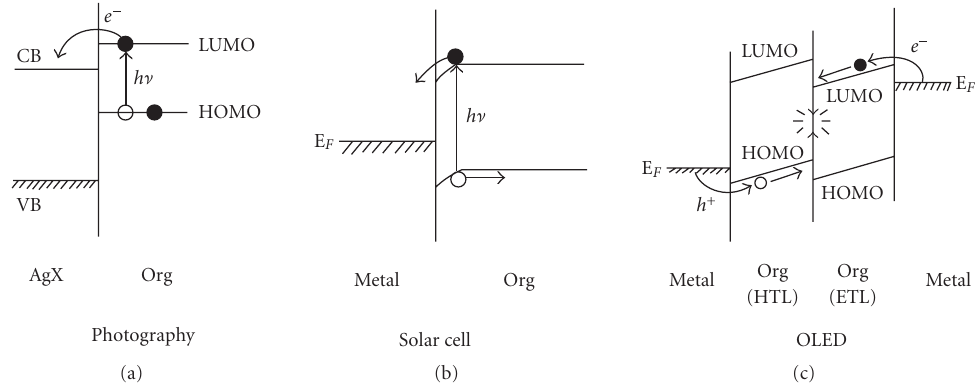
Figure 1: Electronic structures of the interfaces between organic layers and substrates in photography, solar cell, and organic light-emitting device (OLED), where CB and VB are the conduction band and the valence band, respectively, LUMO and HOMO are the lowest unoccupied molecular orbital and the highest occupied one, respectively, E F is the Fermi level of a metal, AgX is silver halide, Org is organic layer, and HTL and ETL are hole transport and electron transport layers, respectively.